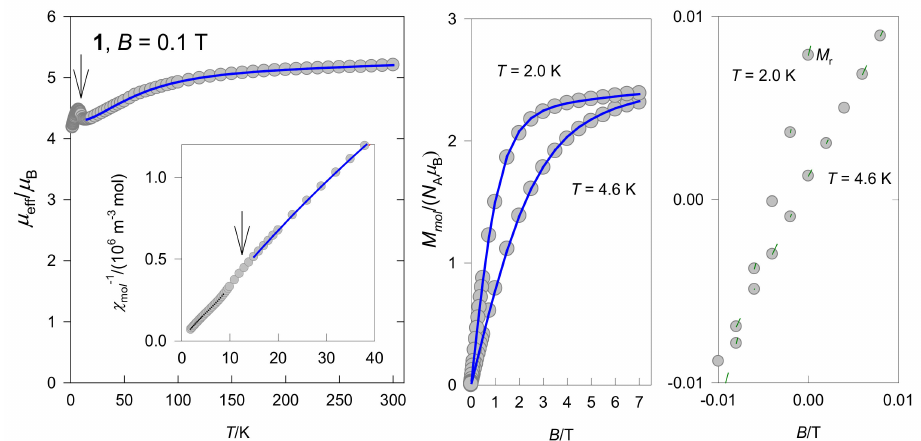
Figure 4. DC magnetic functions for 1 . Inset: inverse molar magnetic susceptibility. Solid lines—fitted susceptibility data above 15 K according to the ZFS model; dashed—linear regression for the data below 8 K. Arrow indicates an